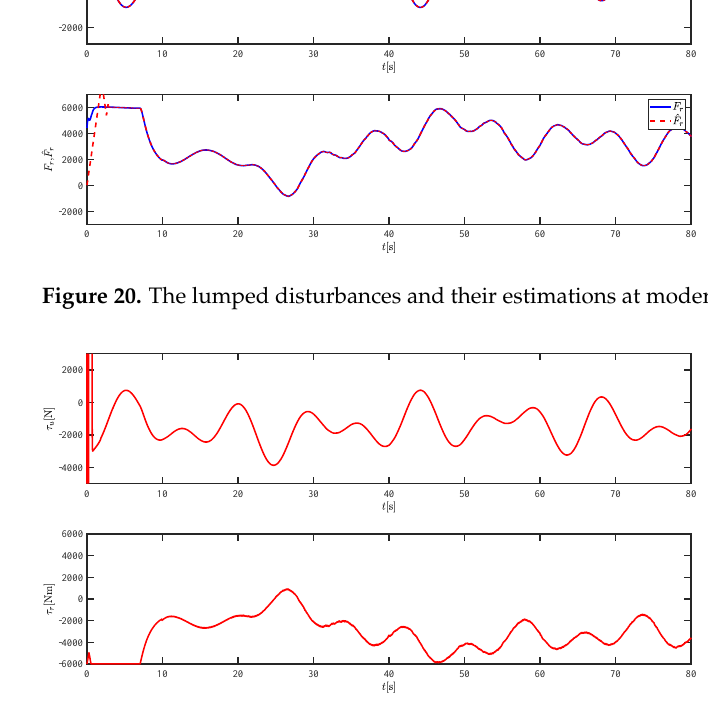
Figure 21. The force τ u and moment τ r at moderate speed.